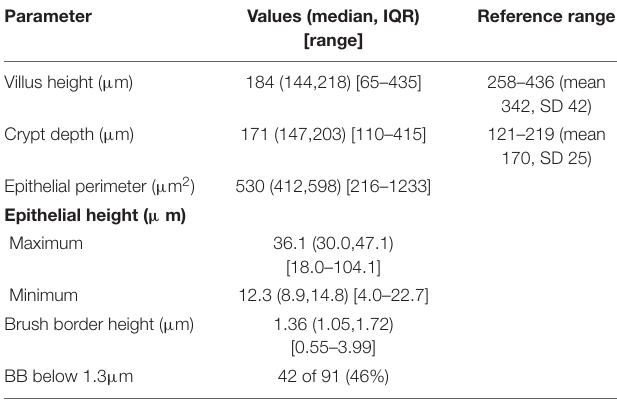
TABLE 2 | Mucosal morphometry in biopsies from 91 stunted children. Parameter Values (median, IQR) [range]